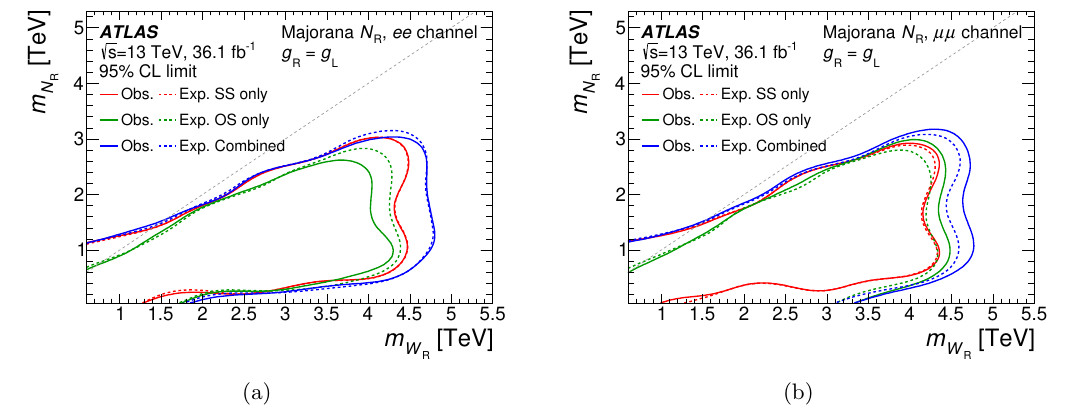
Figure 8 . Observed (continuous line) and expected (dashed line) 95% CL exclusion contours in the m W { m N plane for Majorana N R neutrinos calculated in the OS and SS analyses, and their R R combination, in the (a) ee and (b) (cid:22)(cid:22) channels. The dashed gray line indicates the region of the plane where m W = m N . The left- and right-handed weak gauge couplings are assumed to be the R R same ( g L = g R